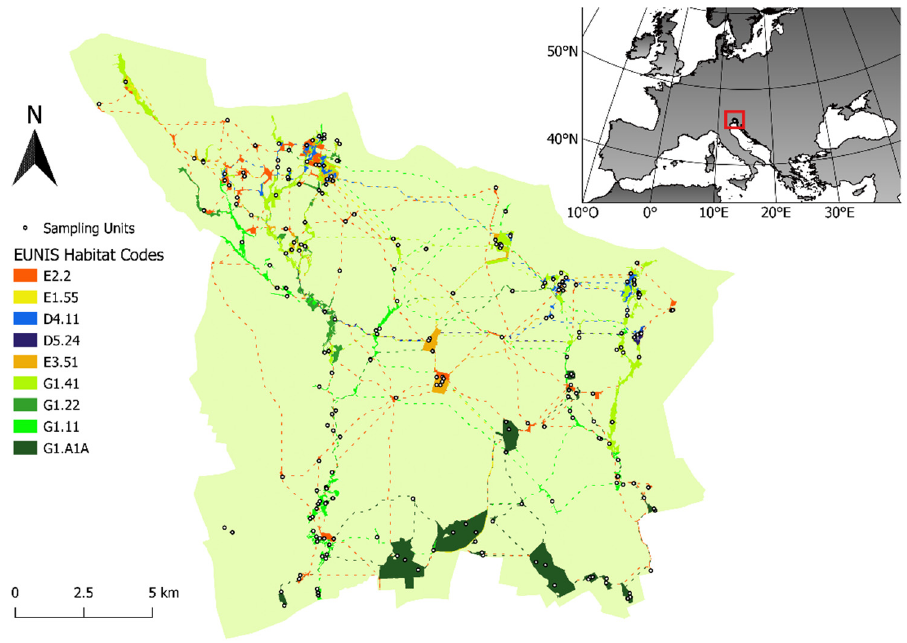
Figure 1. Location of the study area (red square) in relation to the European continent (top right). Representation of the Ecological Network model and location of sampling units within the study area (main figure). Colored lines and patches are corridors and nodes of the network, representing different habitat types and species-specific networks. EUNIS Habitat Codes are as follows: D4.11